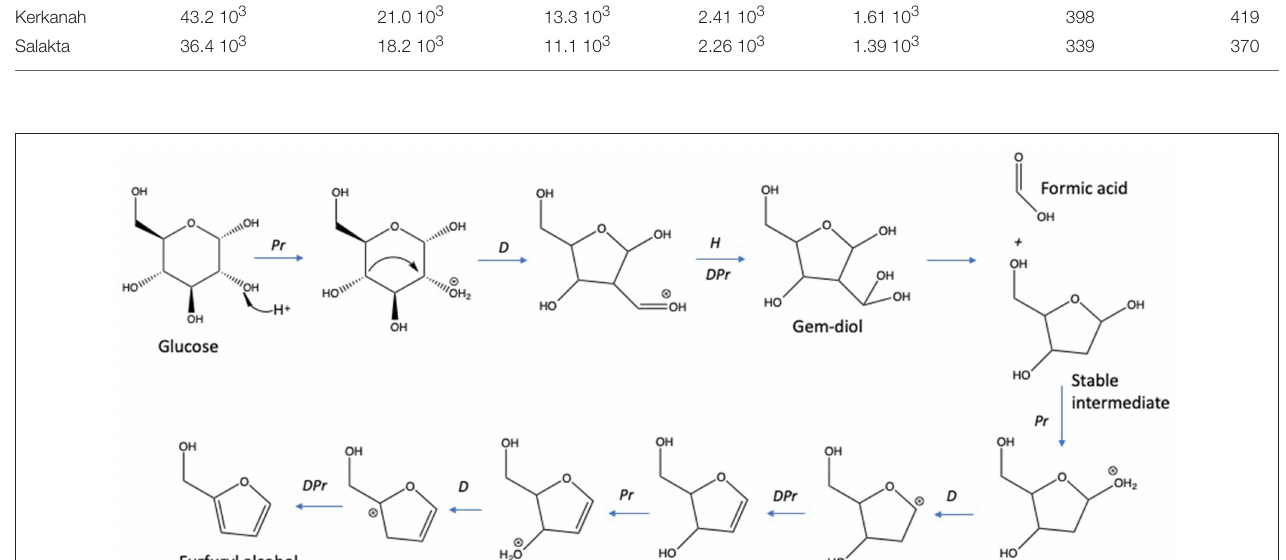
FIGURE 4 | Hydrothermal decomposition of D-glucose to formic acid and furfuryl alcohol (Assary et al., 2012). Reactions: Pr, protonation; H: hydration; D, dehydration; DPr, deprotonation.